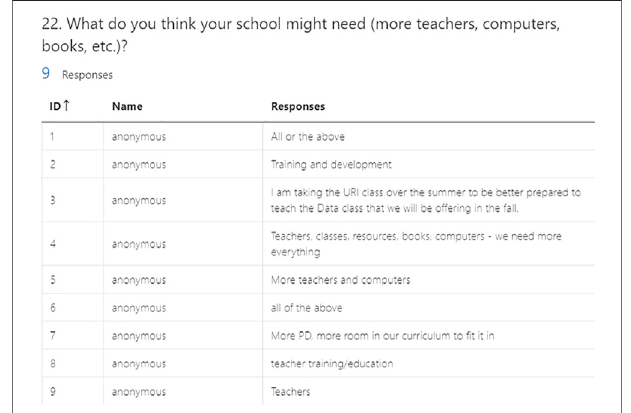
FIGURE 4 | simplechartsri.com landing page.